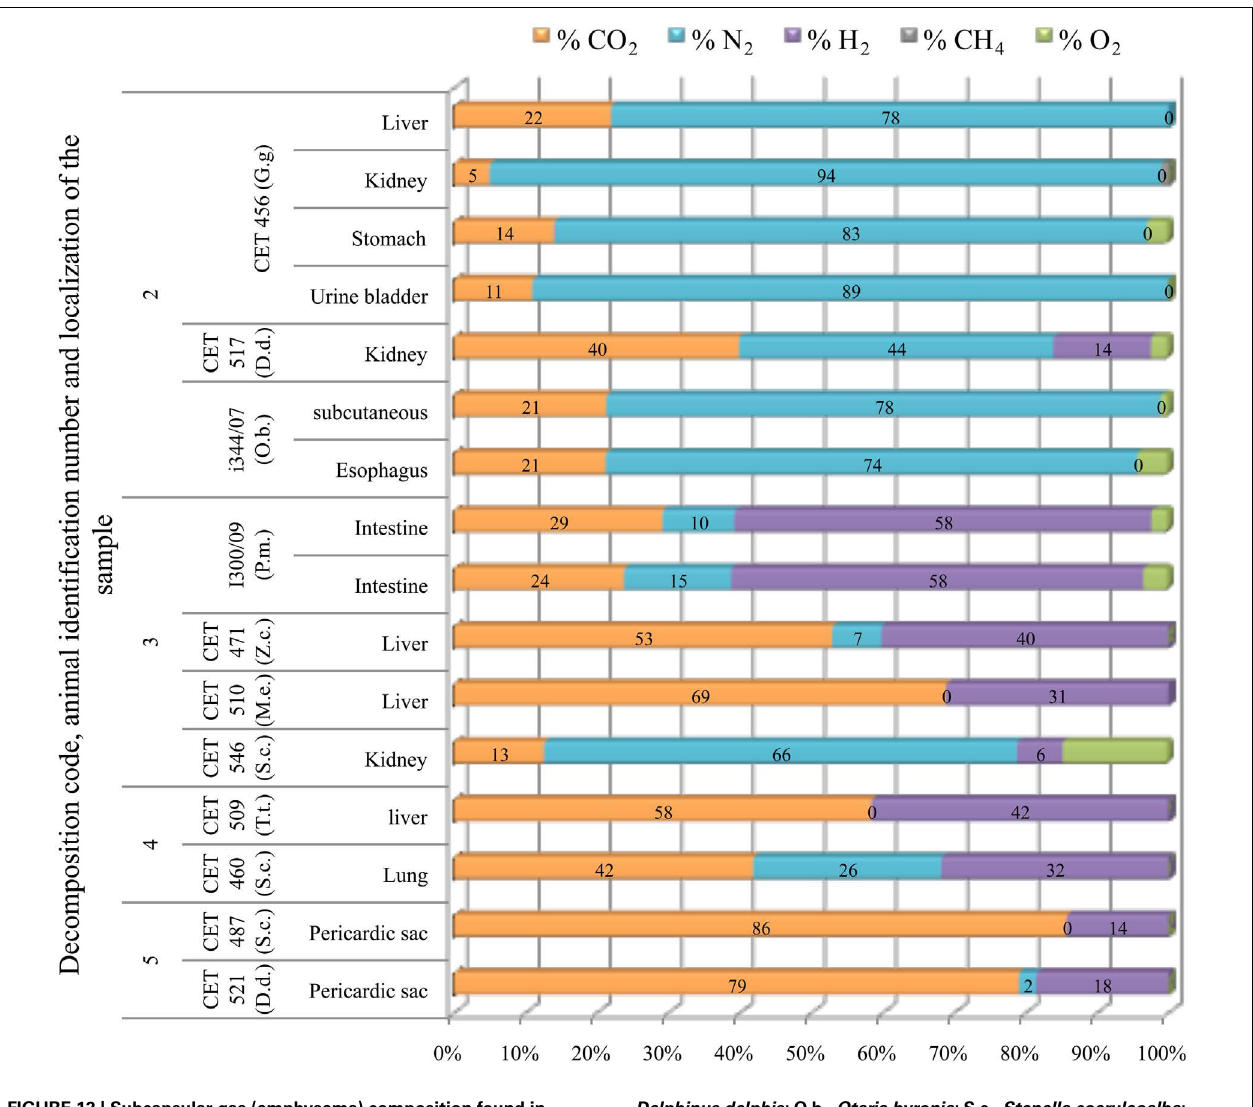
FIGURE 12 | Subcapsular gas (emphysema) composition found in different tissues from deep diving (G.g., Grampus griseus ; D.d., P.m., Physeter macrocephalus ; Z.c., Ziphius cavirostris ; M.e., Mesoplodon europaeus ) and shallow diving animals (D.d.,